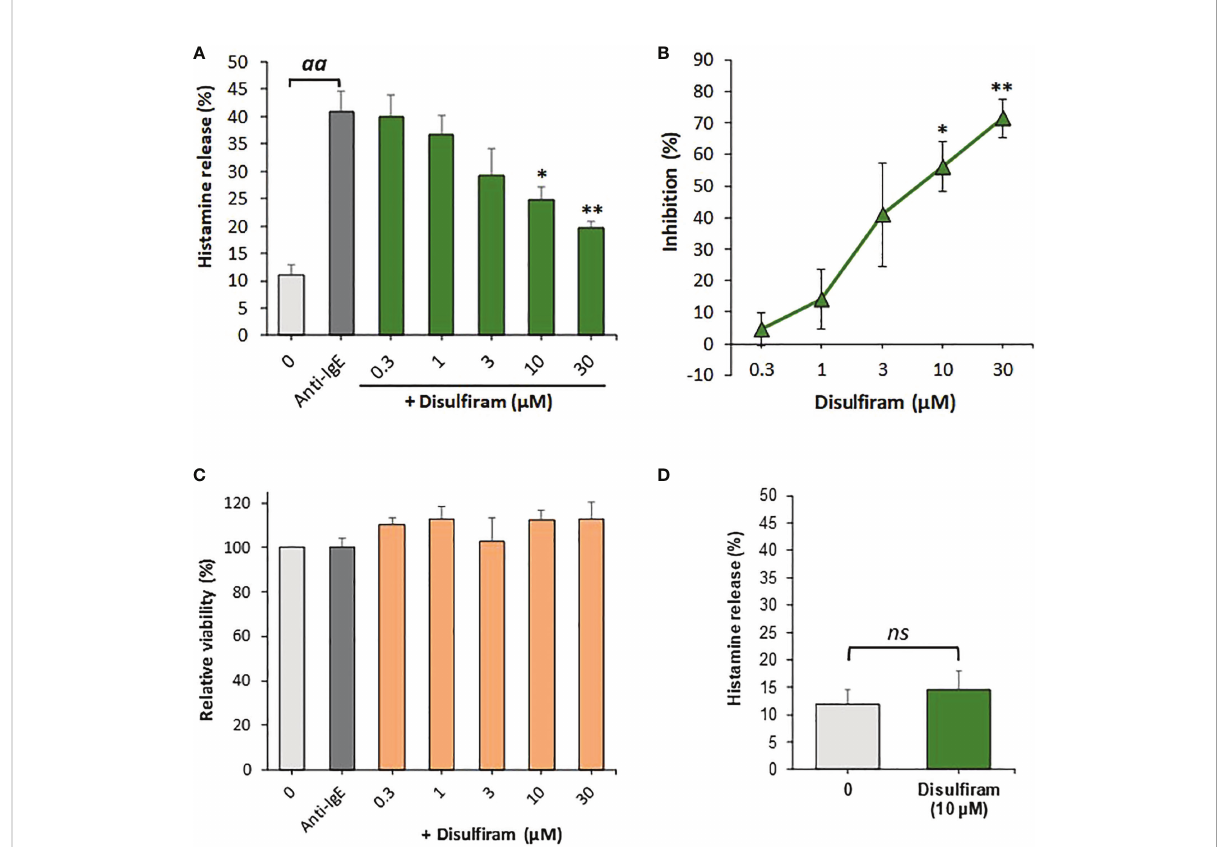
FIGURE 2 Disul fi ram inhibits IgE-dependent histamine release from human basophils. (A) Basophils were preincubated with or without various concentrations of disul fi ram for 15 min at 37°C before stimulation with anti-IgE (1µg/ml) for 30 min (n=5). Results are expressed as relative percentage histamine releases from which (B) the percentage inhibition of anti-IgE-induced histamine release was calculated from net histamine releases (corrected for spontaneous release controls). aa denotes signi fi cant (p<0.01) differences between anti-IgE stimulated positive controls from spontaneous release controls, * and ** indicate signi fi cant (p<0.05 and p<0.01, respectively) differences between anti-IgE alone and basophils incubated with disul fi ram at the indicated concentrations as determined by a one-way ANOVA followed by Holm-Bonferroni correction. (C) Viability, relative to basophils incubated without anti-IgE or disul fi ram, as determined by MTS assay, was not reduced by the treatments (n=4). (D) Disul fi ram did not signi fi cantly (ns; determined using a paired Student ’ s t-test) induce histamine release when incubated with basophils for 45 min at 37°C alone (in the absence of anti-IgE; n=4). Results are expressed as means ± SEM for the indicated number of independent experiments using different basophil